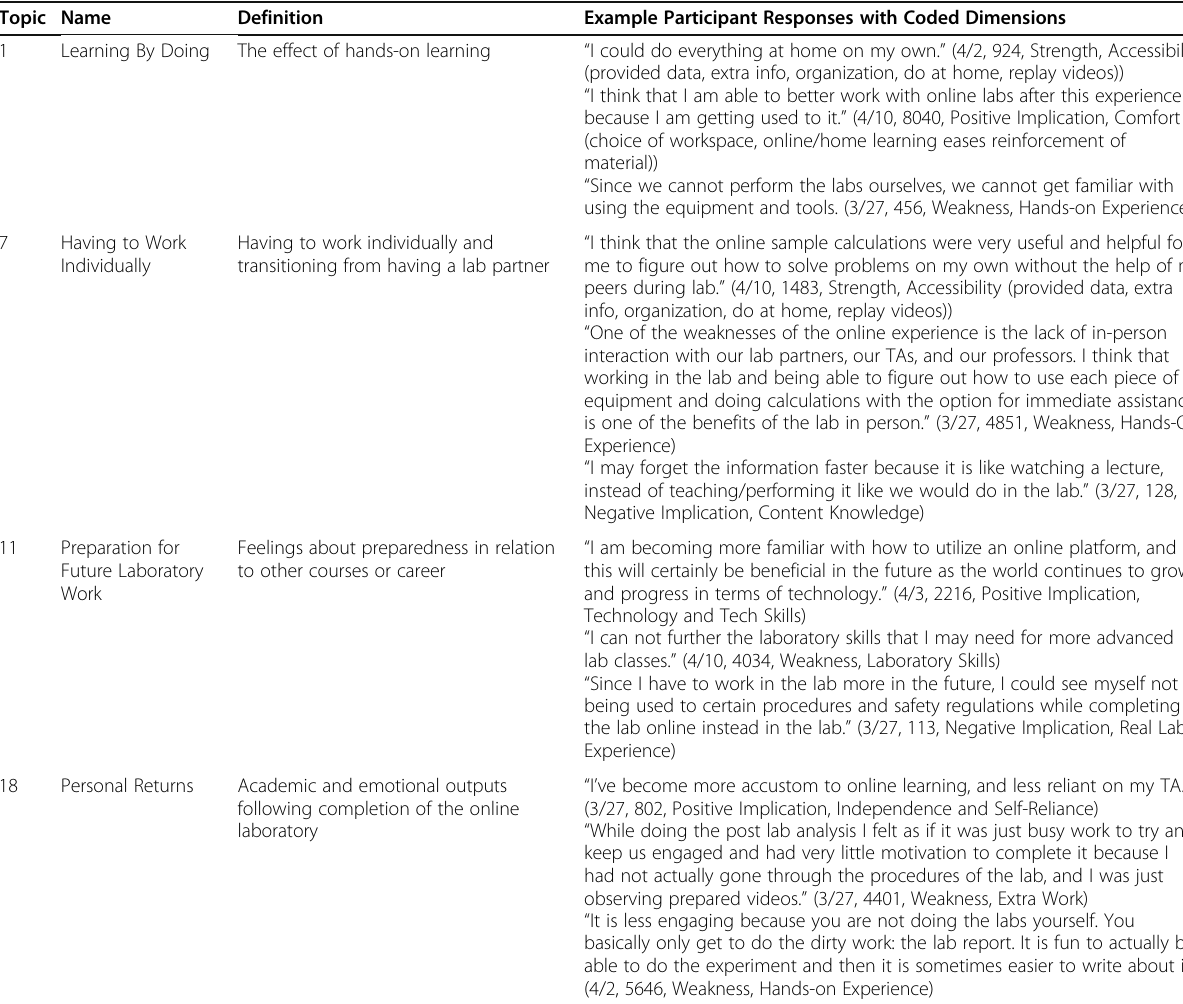
Table 5 Topics and examples of participant responses with coded